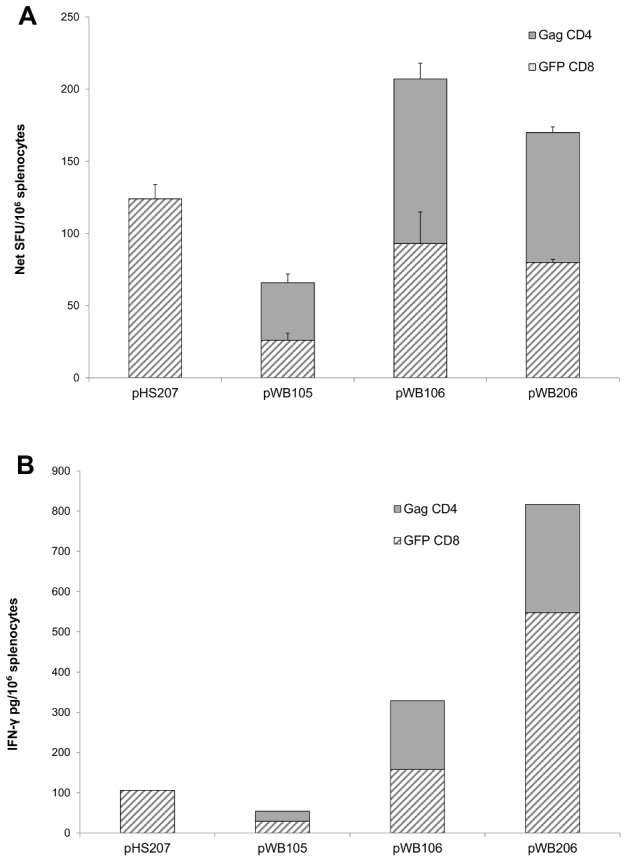
GFP and Gag-Specific immune responses induced by rBCG vaccines.Mice were vaccinated with BCG[pHS207], [pWB105], [pWB106] and [pWB206] (intranasal, 107 CFU). Splenocytes pooled from a group of 5 mice were used on day 56 in A. an IFN-γ ELISPOT assay with the GFPCD8 peptide, GagCD8 peptide or GagCD4 peptide. Bars represent the average number of SFU/106 splenocytes ± the standard deviation of triplicate reactions after subtraction of average background responses of not more than 20±10 SFU per 106 splenocytes. No response to the GagCD8 peptide was detected. B. Splenocytes were cultured (48 h) with the GFPCD8 peptide, GagCD8 peptide or GagCD4 peptide and cytokine levels in the culture supernatant were quantified using a Th1/Th2 cytokine bead array assay and flow cytometry. Only IFN-γ was detected in the culture fluid and for splencoytes stimulated with the GFPCD8 and GagCD4 peptides. Levels are expressed as pg/106 splenocytes and are from a representative experiment.